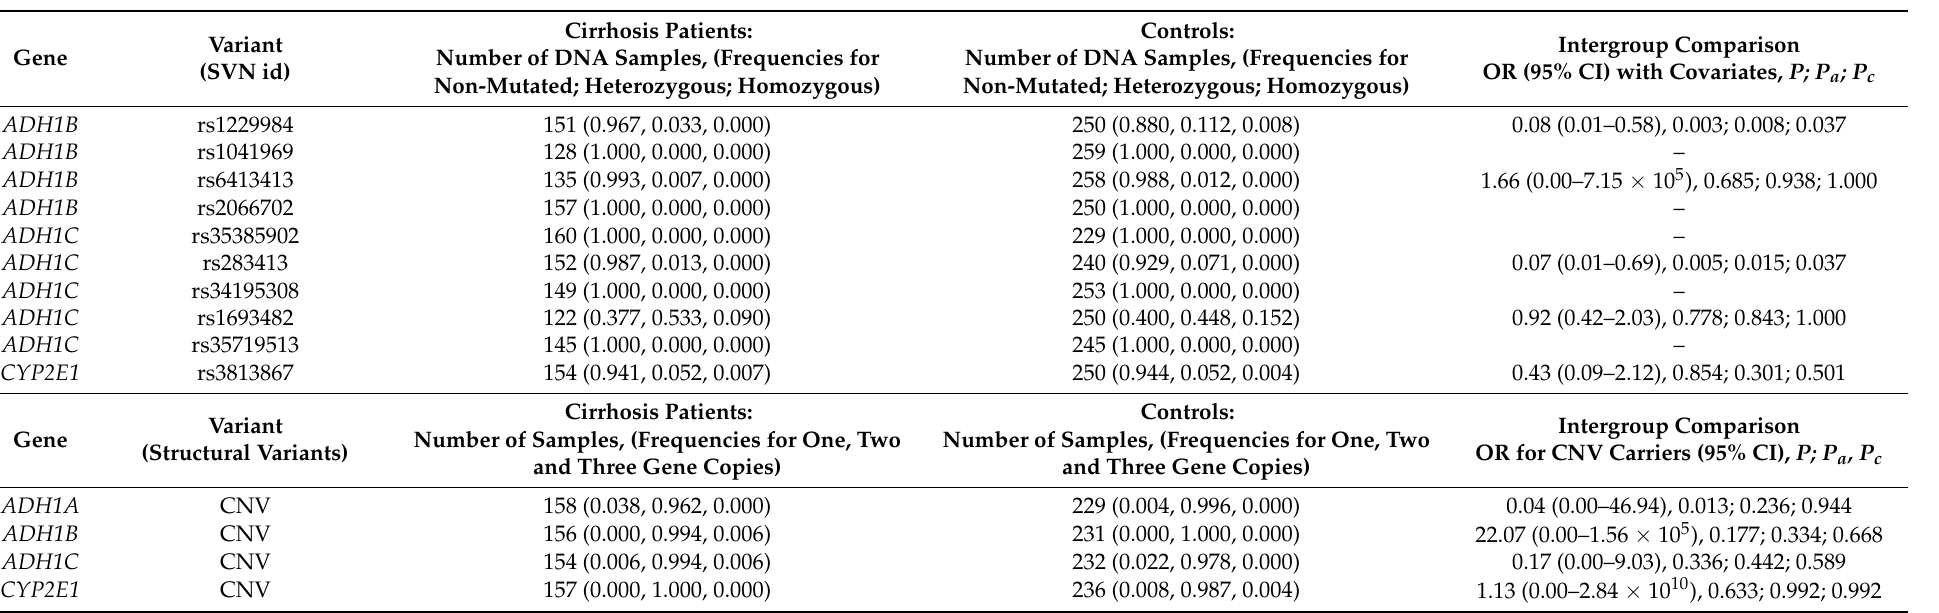
Table 3. Distribution of genotype frequencies of ADH1, ADH2, ADH3 , and CYP2E1 genetic